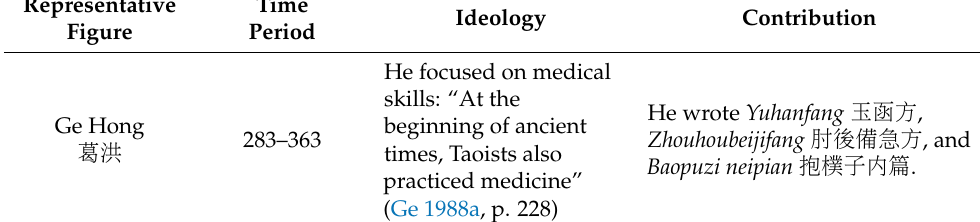
Table 2. The theoretical process of medical knowledge in the Tao-Ge